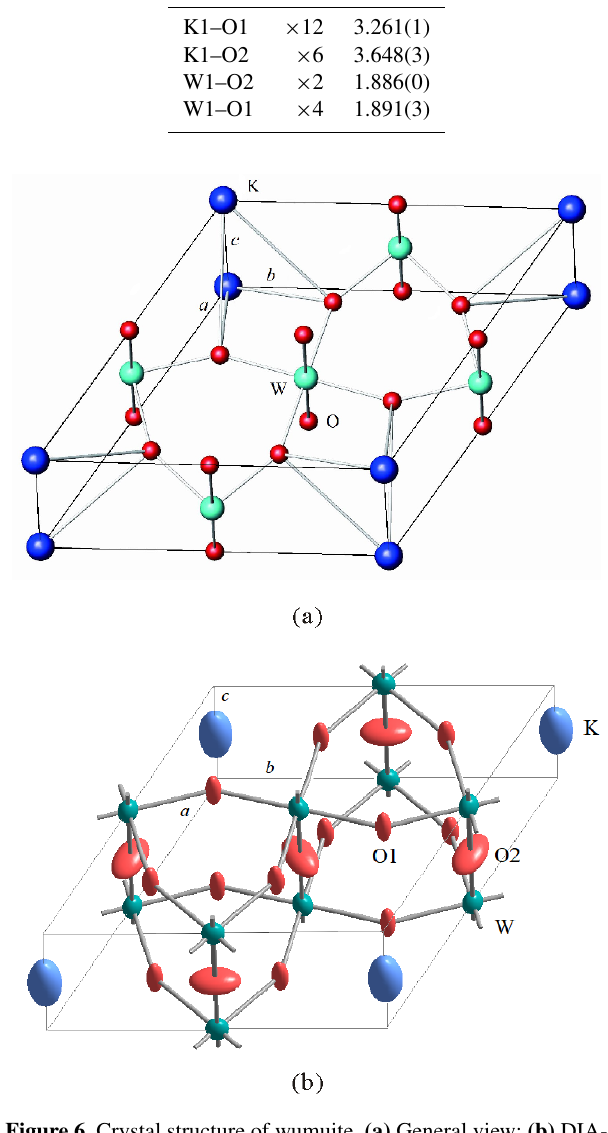
Figure 6. Crystal structure of wumuite. (a) General view; (b) DIA- MOND 3.1 drawing of wumuite with thermal ellipsoid plot (50% probability).